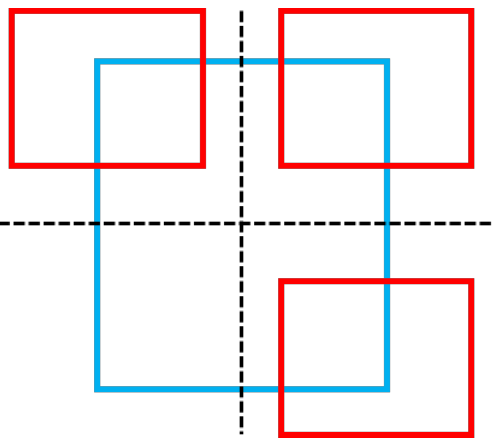
Figure 12. The case of box-to-box symmetry. B at each of the three positions is symmetrical about the midline of B gt , then the value of each version of IoU calculated from B and B gt is the